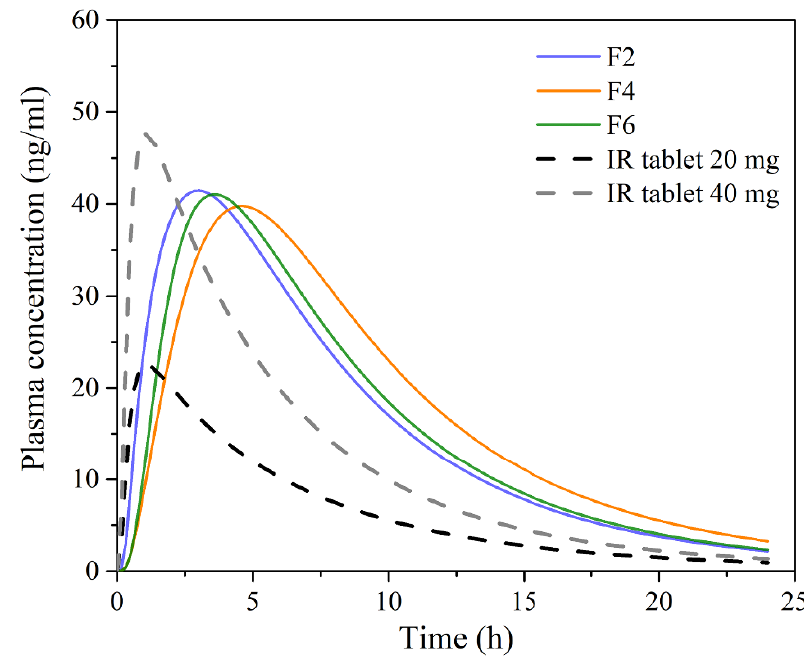
Figure 6. Mean predicted plasma concentration-time profiles following single dosing of the tested 20 mg PRH buccal films, and 20 mg and 40 mg IR tablets in 50 virtual subjects. 20 mg PRH buccal films, and 20 mg and 40 mg IR tablets in 50 virtual